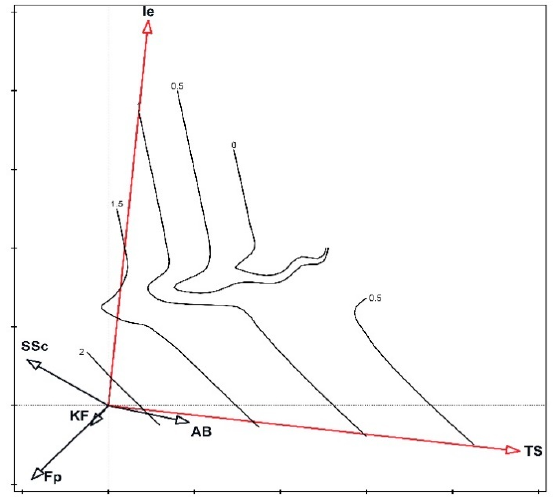
Figure 5. Diversity (H (cid:48) ) in the ordination plot (CCA). Vectors marked in red represent variables that are statistically significant for diversity in the model. Legend: AB— Adonido – Brachypodietum pinnati , Fp— Festucetum pallentis , Ie— Innuletum ensifoliae , KF— Koelerio – Festucetum , SSc— Seslerio – Scorzoneretum purpureae , TS— Thalictro – Salvietum pratensis